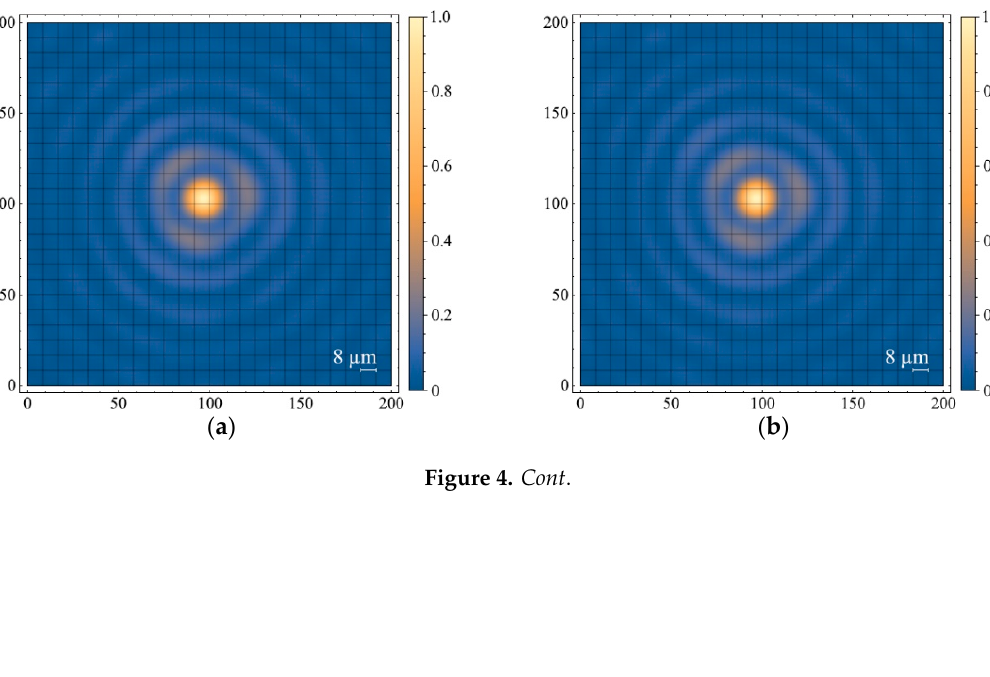
Figure 3. Axial intensity distributions of a zero-order Bessel beam and gradient from the longitudinal coordinate z AP for various parameters of the binary mask in front of the axicon: ( a ) without binary mask, d = 0 mm, D → ∞ ; ( b ) with binary mask, d = 4 mm, D → ∞ ; ( c ) with binary mask, d = 0, D = 7 mm; ( d ) with binary mask, d = 4, D = 7 mm.